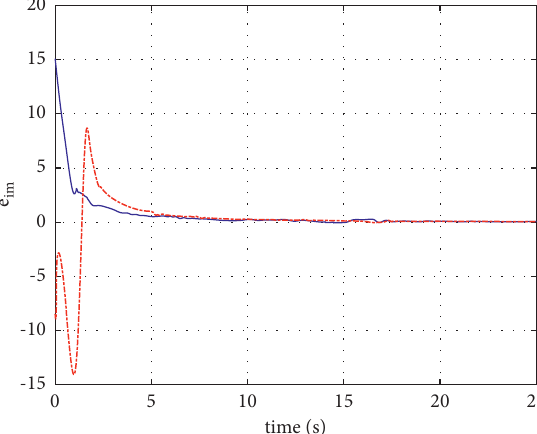
Figure 2: Performances of auxiliary errors e